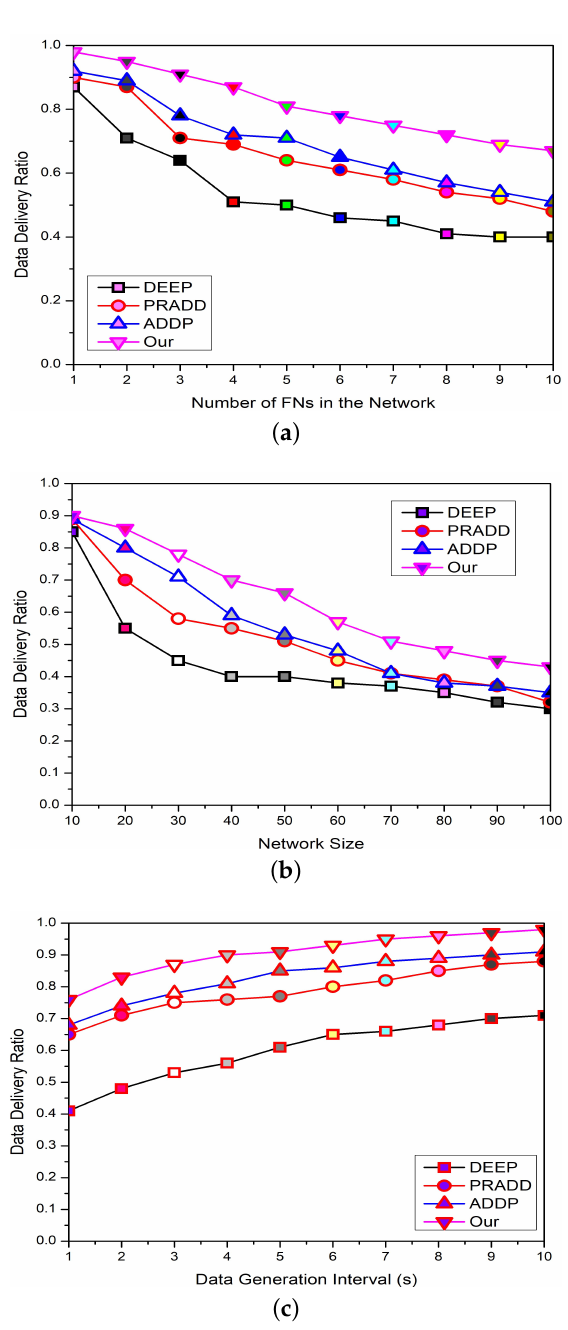
Figure 8. The comparison of data delivery ratio of our proposed framework with different values of number of field nodes, network size, and data generation